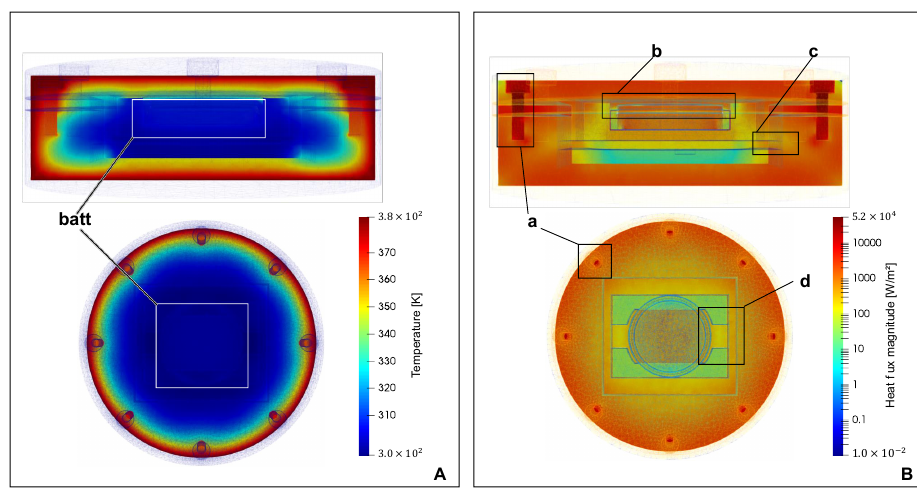
Figure 12. Simulation results—state after first temperature peak during the sterilization displaying temperature ( A ), and heatflux ( B